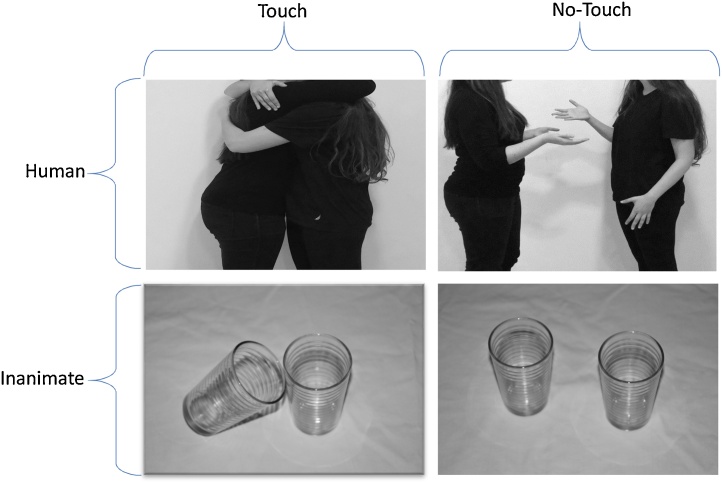
Photos illustrating each of the four conditions explored in the study. Note that both inanimate objects and humans were photographed against a white background. All humans wore black clothing and were photographed from the shoulders down in order to avoid the confounding effects of facial expressions.